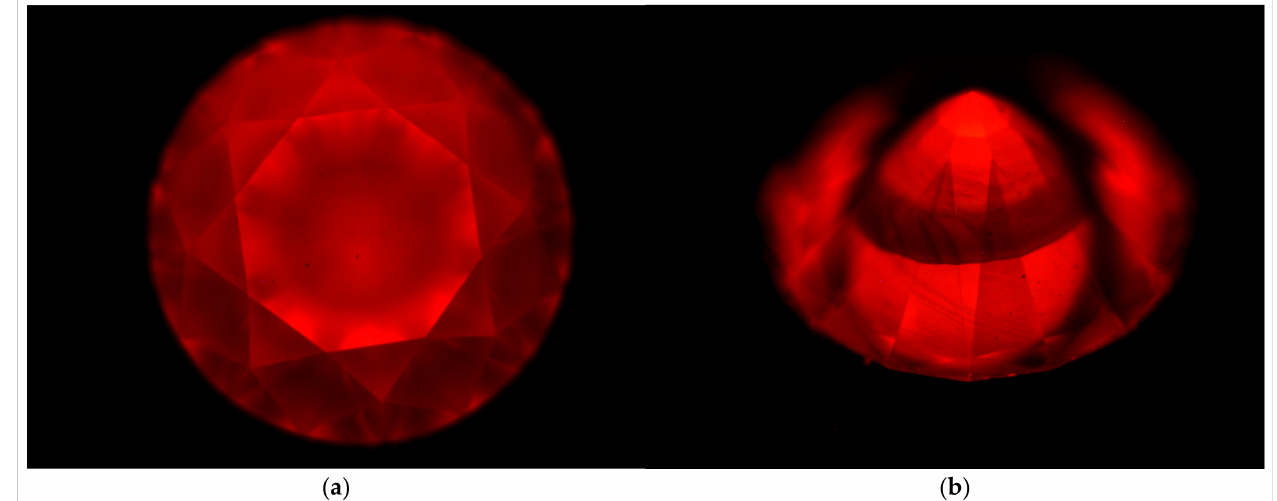
Figure 4. In DiamondView, these pink CVD diamonds display strong orange or orange red fluorescence. The fluorescence pattern of the ZX03 shown here is indistinct from the table ( a ), and the characteristic striated growth features are clearly seen from the pavilion ( b ). Photos by Z.